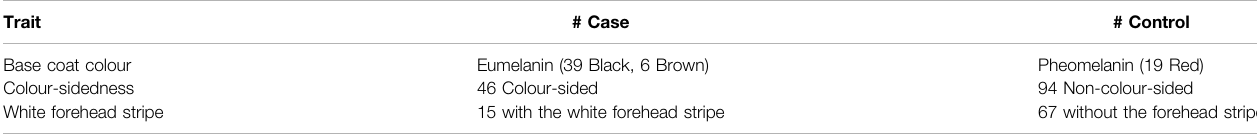
TABLE 1 | Case-control GWAS tests used for the generation of Manhattan